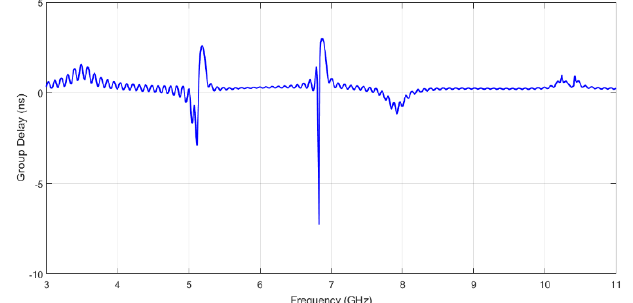
Figure 12: The group delay of propose antenna with two HSRRs ESRR4 and ESRR2 with rotational angles θ θ =-45˚ 2 =45˚ and θ =-45˚ 1 2